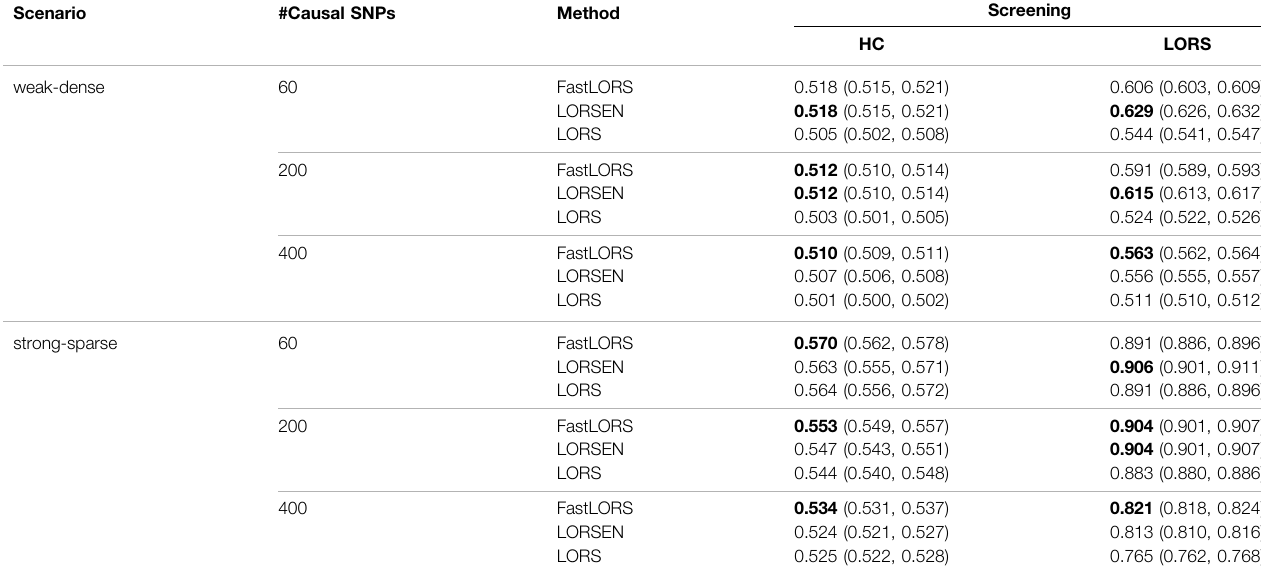
TABLE 6 | The average AUC and 95% con fi dence interval with the SNP screening with ten replicates for each simulation scenario. SNPs are from chromosome 1 and chromosome 21. For each simulation scenario, the highest AUC is in bold. ScreeningScenario #Causal